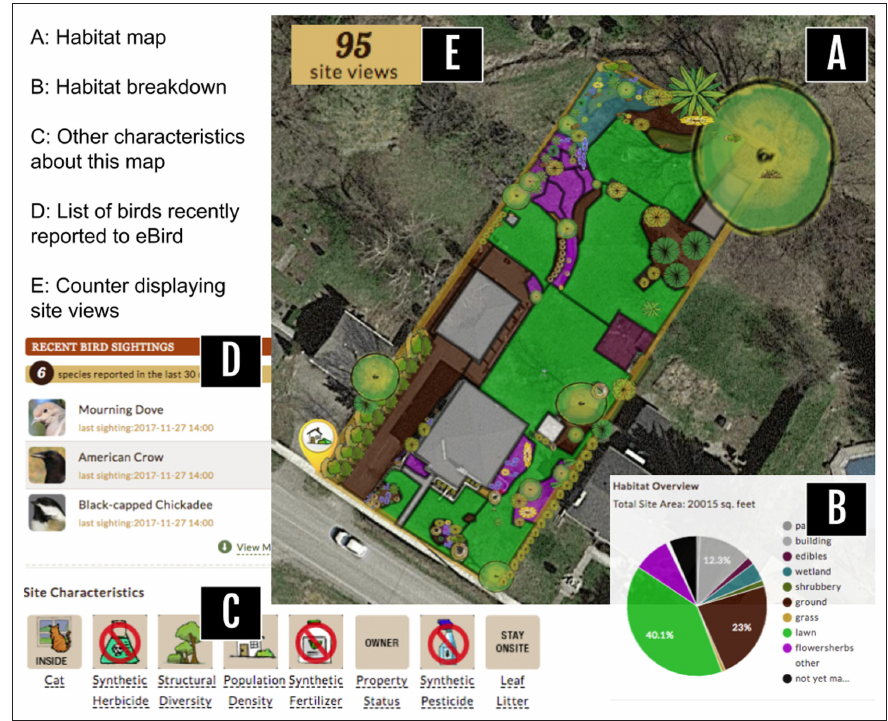
Figure 1: Example of participant-generated YardMap. Participants in the social version can view each other’s yard prac- tices (site characteristics), habitat types, and birds seen as well as forum comments and the news feed of all